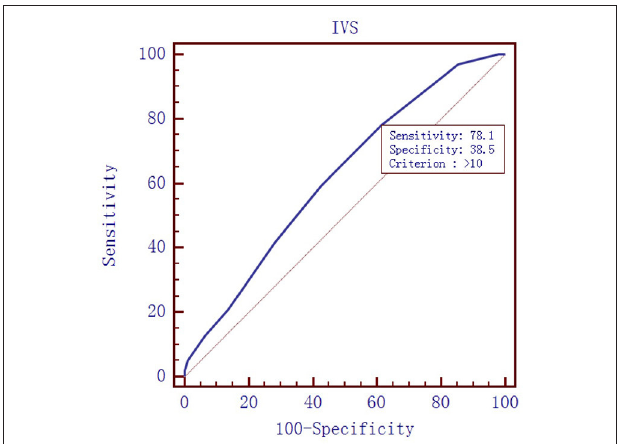
FIGURE 2 | Receiver operating characteristic curve of interventricular septal (IVS) thickness to diagnose HFPEF. Area under the curve: 0.619, 95% C.I. (0.546–0.688), P = 0.0028.